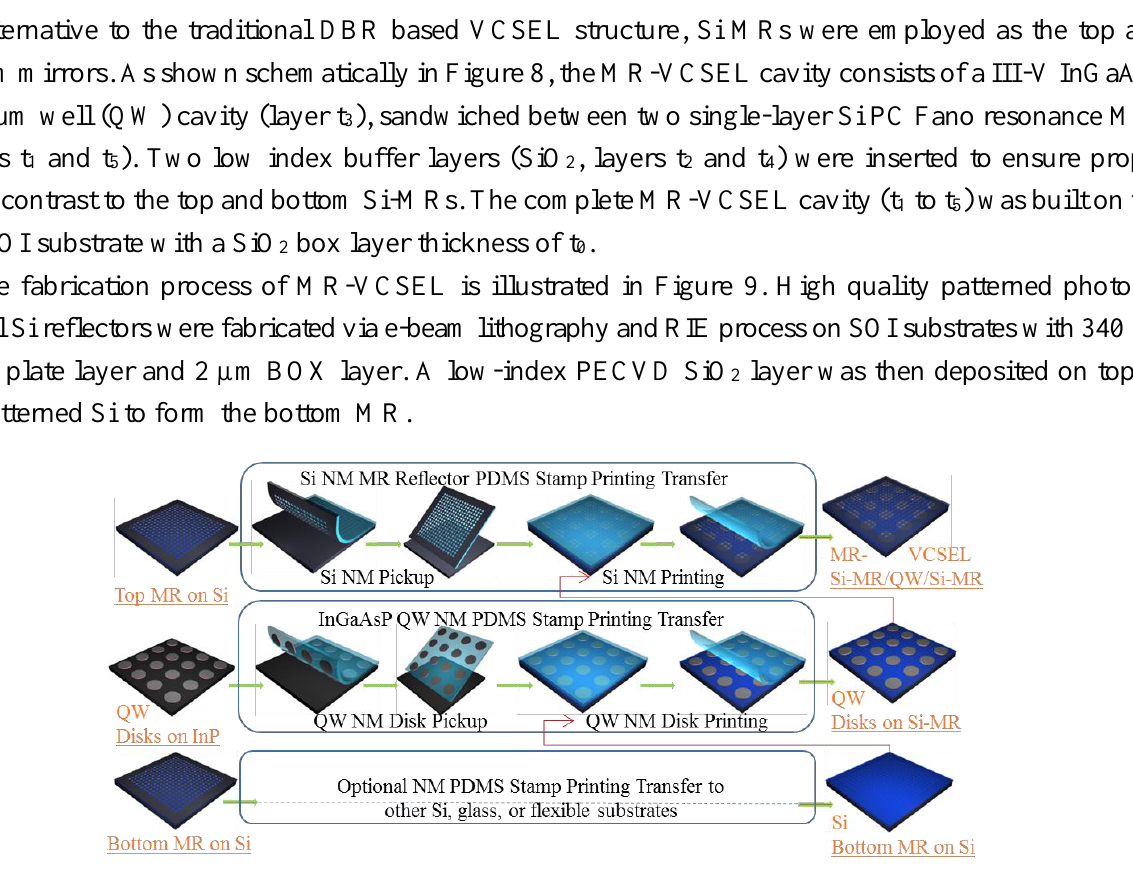
Figure 9. MR-VCSEL fabrication based on nanomembrane (NM) PDMS stamp printing process. Reproduced with permission from